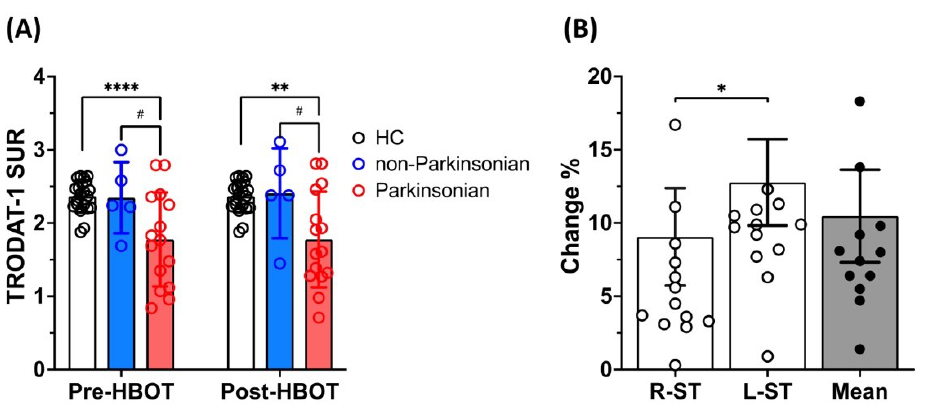
Figure 4. Dopamine transporter (DAT) availability (SURs) for both sides of striatum, as measured by 99mTc-TRODAT-1 SPECT in healthy controls and patients with non-Parkinsonian or Parkinsonian groups before and after HBOT. ( A ) Dopamine transporter (DAT) availability had significant lower in the Parkinsonian group when compared to non-Parkinsonian or health control groups; ( B ) Change (%) in dopamine transporter (DAT) availability (SURs) in the right and left striata (white circles) and in both sides of the striatum (black circles) before and after HBOT. Data are mean ± SD; * p < 0.05; * * p < 0.01; **** p < 0.001; # p < 0.05 (paired t